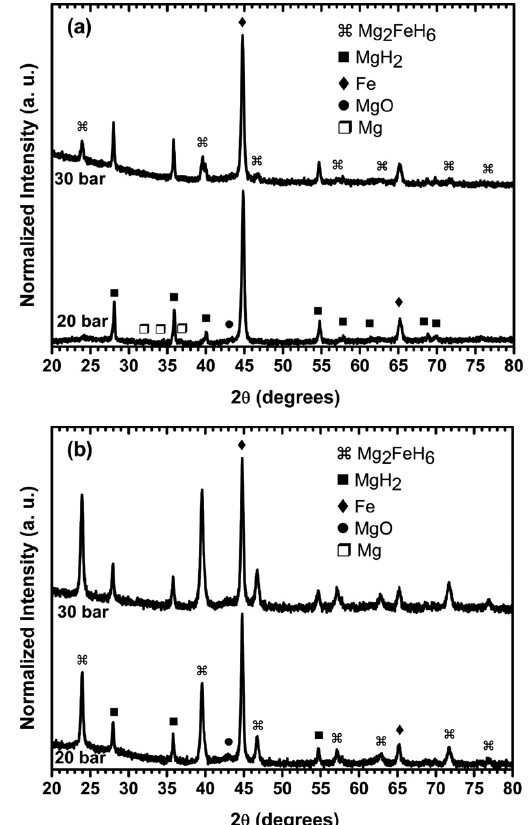
Figure 3. Curves of hydrogen absorption kinetics of 2Mg-Fe sample at 350 °C under 20 and 30 bar of H behaviour at the first 20 minutes and during 20 hours are shown in (a) and (b) respectively.